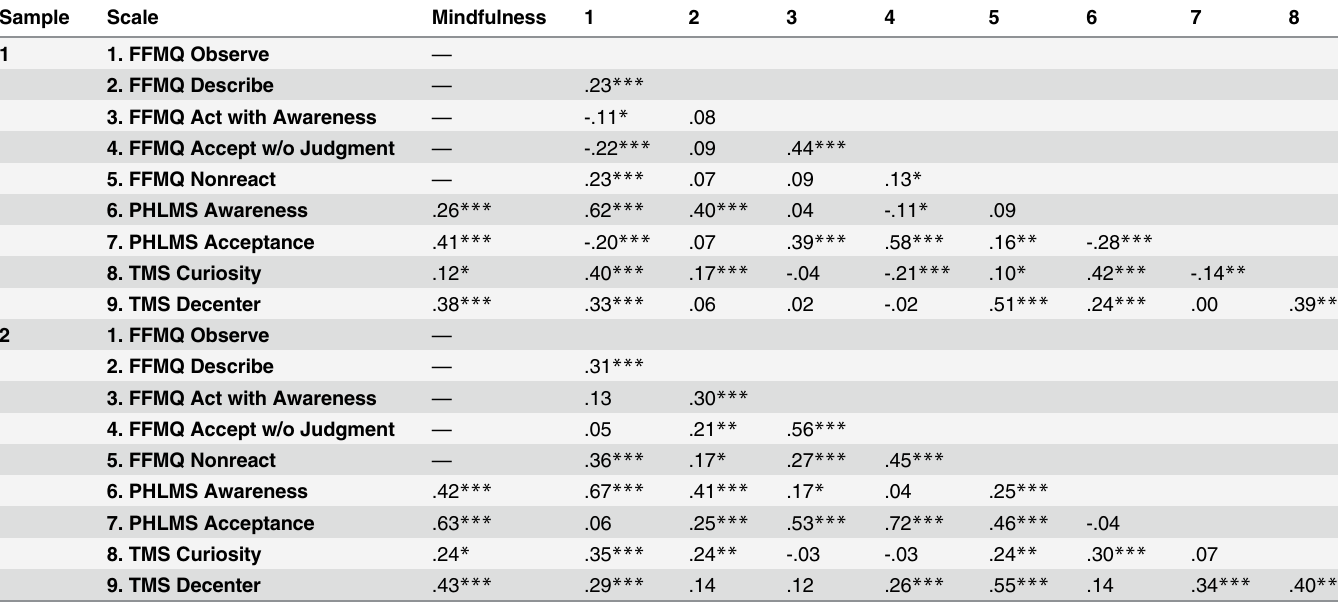
Table 4. Intercorrelations among FFMQ Facets, PHFLMS and TMS Subscales, and the Global Mindfulness Component. Sample